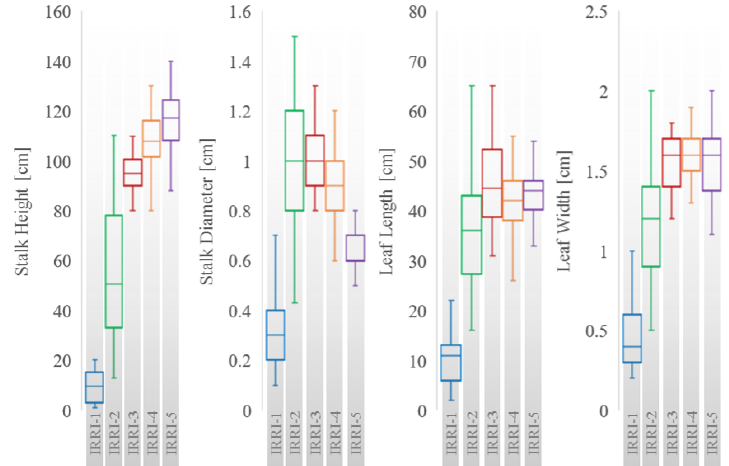
Figure 3. Temporal variations of the rice crop biophysical collected between 2013–2015 from the regularly conducted ground campaigns in Ipsala (Turkey). Due to technical limitations, stalk diameter data was not measured in 2015. The measurements are grouped according to the IRRI growth phases as a Box-and-Whisker plot. Box presents the information for the quartiles while the whiskers present minimum and maximum values for IRRI growth stages IRRI-1 [Early vegetative], IRRI-2 [Late vegetative], IRRI-3 [Early reproductive], IRRI-4 [Late reproductive], IRRI-5